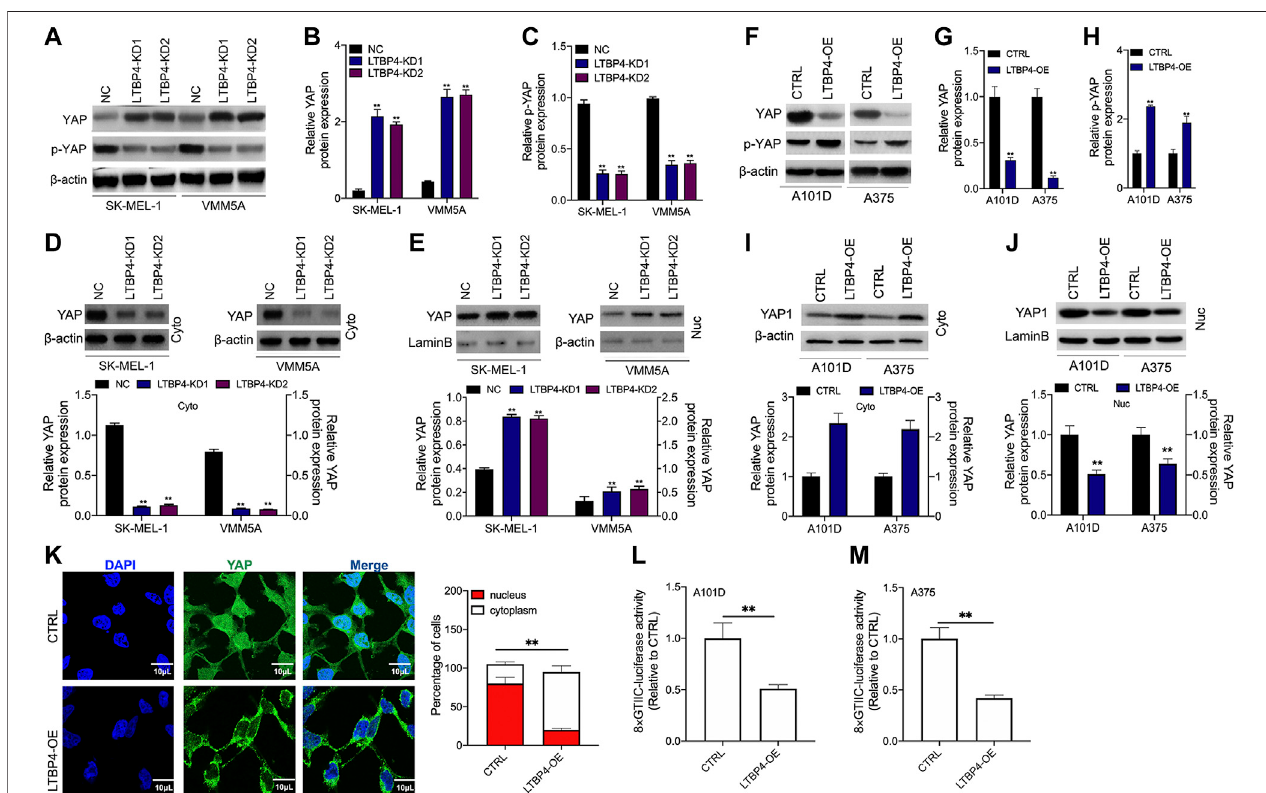
FIGURE 6 | LTBP4 inhibited the transcriptional activity of YAP1 by promoting YAP1 nuclear-cytoplasmic translocation and its phosphorylation. After shRNA- LTBP4#1 or #2 was transfected into SK-MEL-1 and VMM5A cells, the expressions of MST1 and MOB1 (A , B) , the phosphorylation level of MST1 and MOB1 (C) , and cytoplasmic YAP1 expression (D) and nuclear YAP1 expression (E) were detected by western blotting. After LTBP4 expressing plasmids transfected A101 and A375 cells, the expressions of MST1 and MOB1 (F , G) , the phosphorylation level of MST1 and MOB1 (H) , and cytoplasmic YAP1 expression (I) and nuclear YAP1 expression (J) were detected by western blotting (K) The nuclear-cytoplasmic translocation of YAP1 in A101D cells transfected with LTBP4-overexpression vector was examined by immuno fl uorescence assay (L and M) The luciferase activity of 8xGTIIC-luciferase, a YAP-responsive synthetic promoter driving luciferase expression plasmid,wasevaluatedinA101DandA375cellsfollowingLTBP4-overexpressionvectortransfectionornotransfection. β -actinandLaminBwereusedasaloadcontrol. Data are presented as the mean ± standard deviation. ** p < 0.01 vs CTRL group.